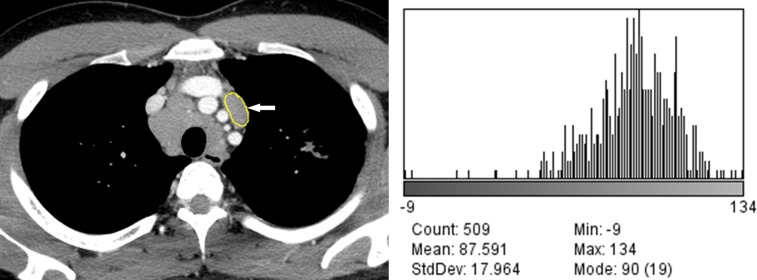
33-year-old man with sarcoidosis with lung involvement.(A) Mediastinal window image of contrast-enhanced chest CT scan shows a segmented prevascular lymph node (arrow). (B) Histogram plot shows the CT data profile of the segmented lymph node (skewness, -1.56; kurtosis, 5.26).